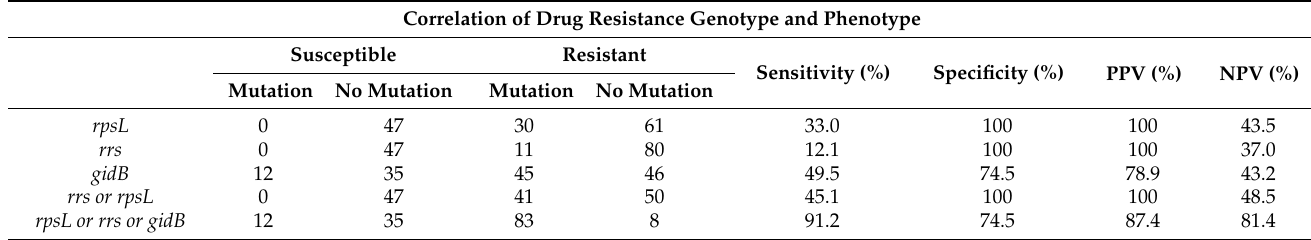
Table 4. STR resistance prediction by mutations in rpsL , rrs and